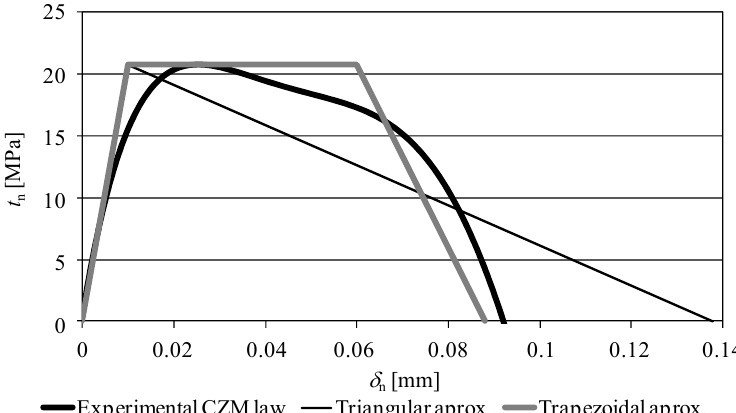
Figure 8: Experimental t n -  n law for one test